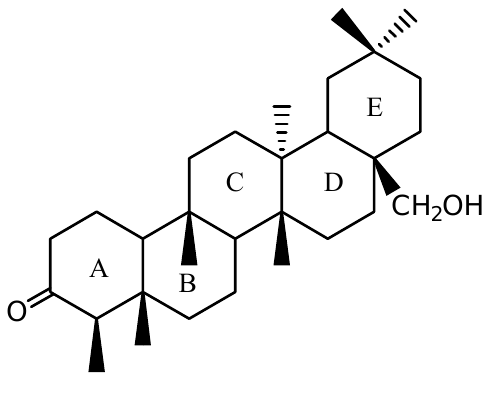
Figure 2. The structure of compound 1.